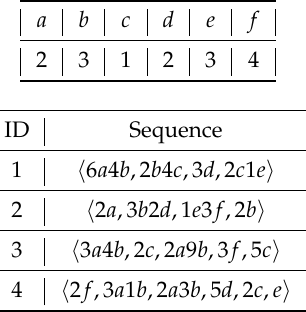
Figure 2. Example profit table and sequence